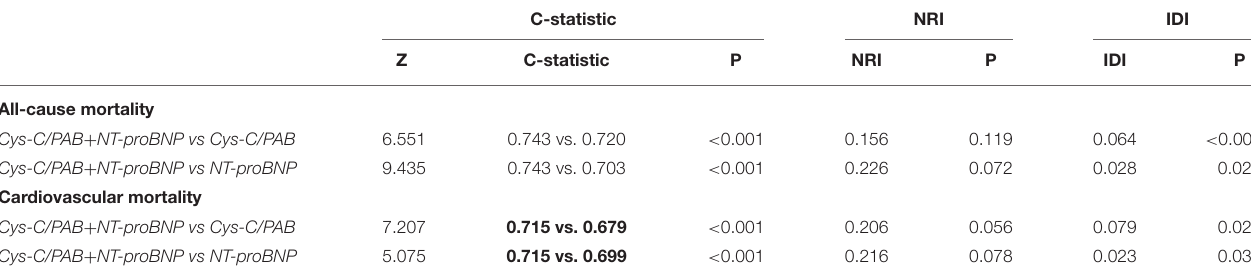
Bold values indicates comparation of C-statistic values of Cys-C/PAB + NT-proBNP and C-statistic values of NT-proBNP.